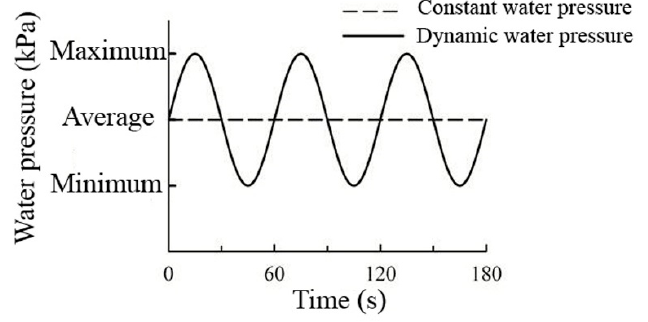
Figure 3. Sinusoidal oscillating water pressure.